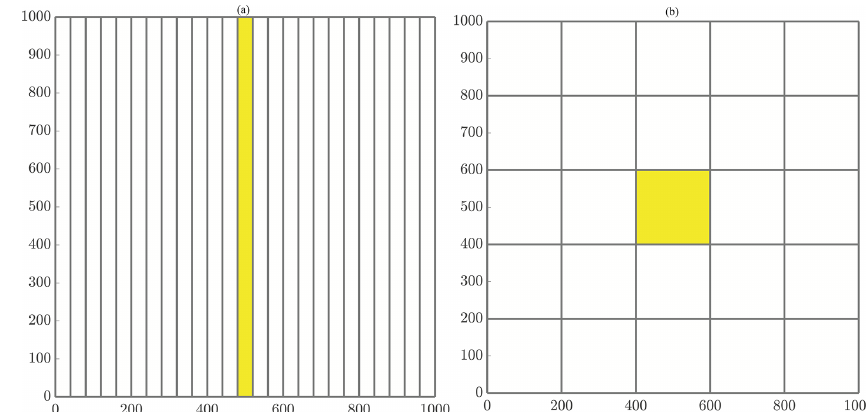
Figure 2. General schematics of (a) slices and (b) checkerboard domain decompositions. (a) Decomposing the domain with 25 cores using the slices method. Figure 4a displays an enlarged slices domain with a description of ghost particle movement as well. (b) Decomposing the domain with 25 cores using the checkerboard method. Figure 4b displays an enlarged checkerboard domain with a description of ghost particle movement as well.